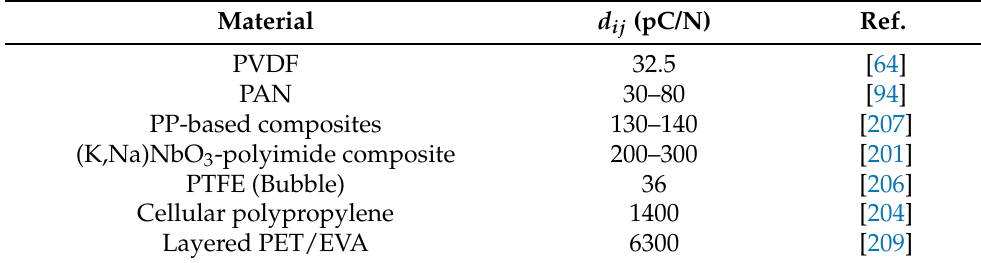
Table 4. Comparison of piezoelectric coefficient for electret materials.